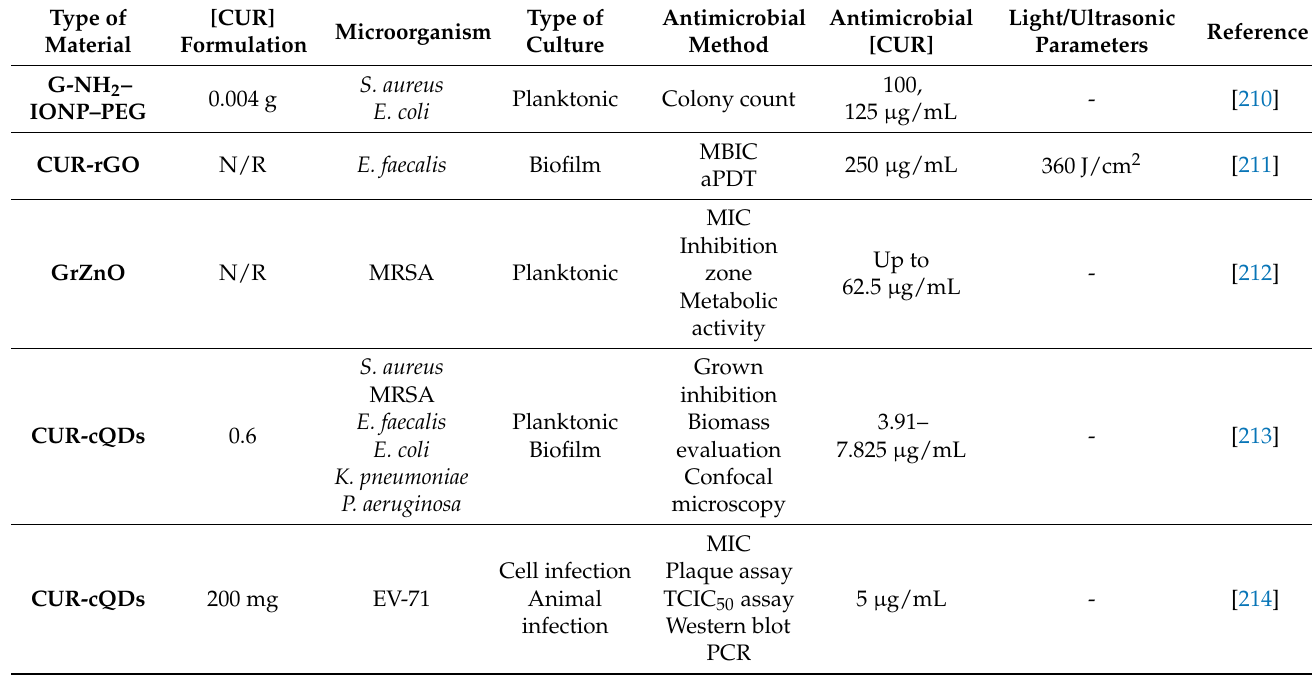
Table 10. Antimicrobial studies performed with CUR in the composite of graphene and quantum dots (QDs). Type